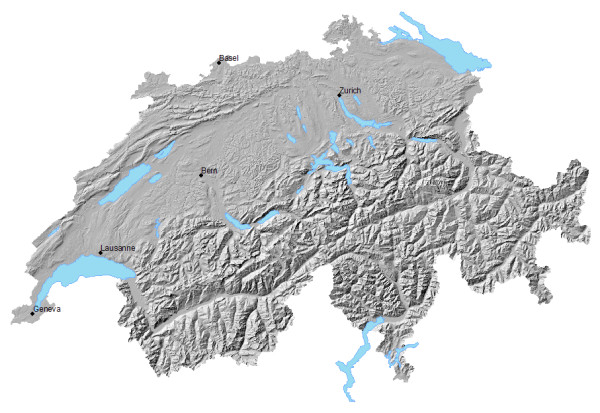
Swiss Topography.